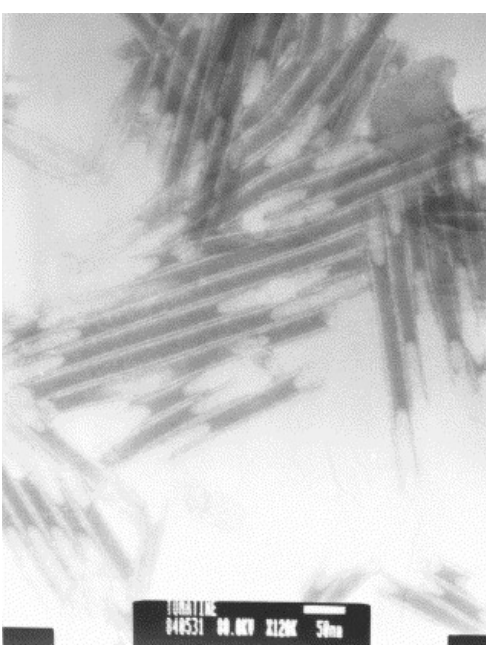
Figure 4. Transmission electron micrograph of tomatine in 0.9% NaCl, showing its stacking hollow tubular structure (left panel). Transmission electron micrograph of the microstructure of the tomatine adjuvant in the major band after isopycnic ultracentrifugation (RI = 1.398 in the sucrose gradient), showing the aggregated gel crystalline microstructure with flaky needle-shaped morphology. Reproduced with permission from reference [69], copyright 2002 (Elsevier).